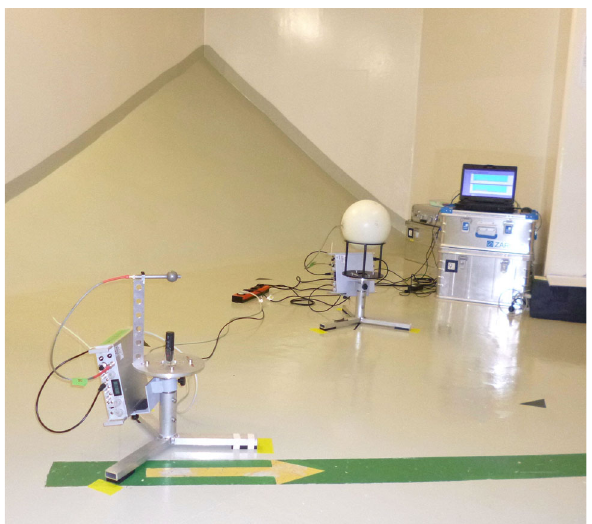
Table 5 Overview of data sets collected during the measurement campaigns with the NEMUS spectrometer in room A408 at KBR